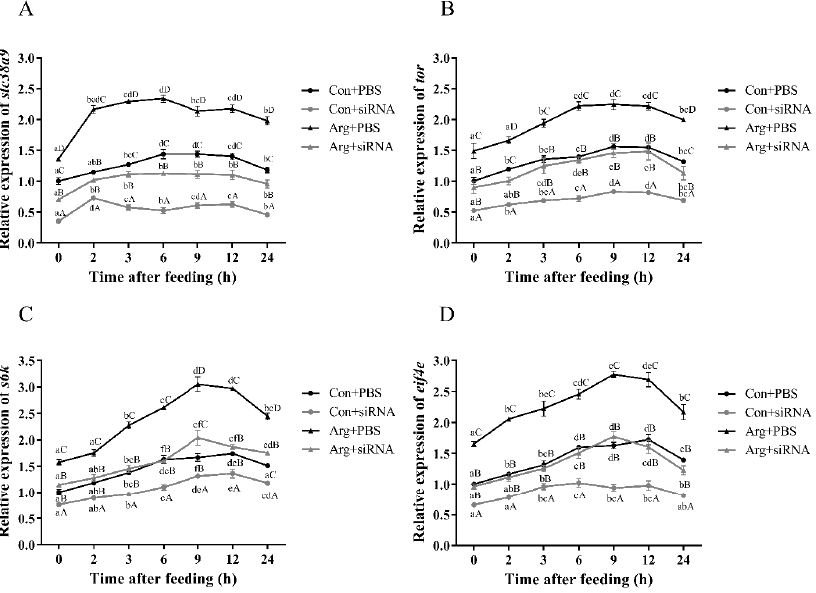
Figure 6. Effect of slc38a9 knockdown on the activation of the TOR signaling pathway by dietary arginine. Abalones were fed with basal (1.23% arginine) and arginine-added (1.72% arginine) diets for two weeks before siRNA knockdown, abalones fed with basal diet served as the control group. After 12 h of siRNA injection, abalones were fed with the original diets. The figure shows the relative expression levels of ( A ) slc38a9 , ( B ) tor , ( C ) s6k and ( D ) eif4e in muscle at different times after feeding. Results are represented as mean ± SEM, N = 3 replicate experiments. Different lowercase letters (a < b < c < d) indicate significant differences of the same group at different times, and capital letters (A < B < C < D) indicate the significance of different treatments at the same time ( p < 0.05). The relative expression levels of slc38a9 , s6k and eif4e were increased significantly when the concentration of arginine was 0.5-4 mmol/L ( p < 0.05), and there was no signifi- cant difference among them ( p > 0.05). Compared with the control group, the addition of arginine up-regulated the relative expression of tor ( p < 0.05). Furthermore, 1-4 mmol/L arginine significantly increased the relative expression of 4e-bp ( p < 0.05) (Figure 7).